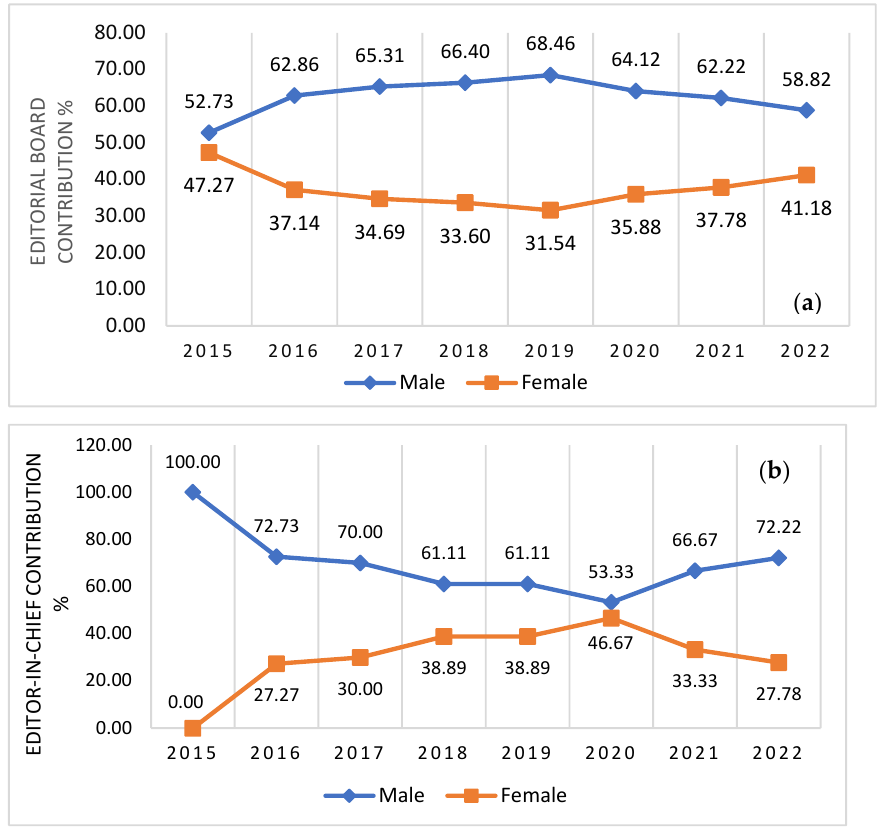
Figure 6. Gender representation on journal editorial boards ( a ) and Editors-in-Chief ( b ) over the last eight years.